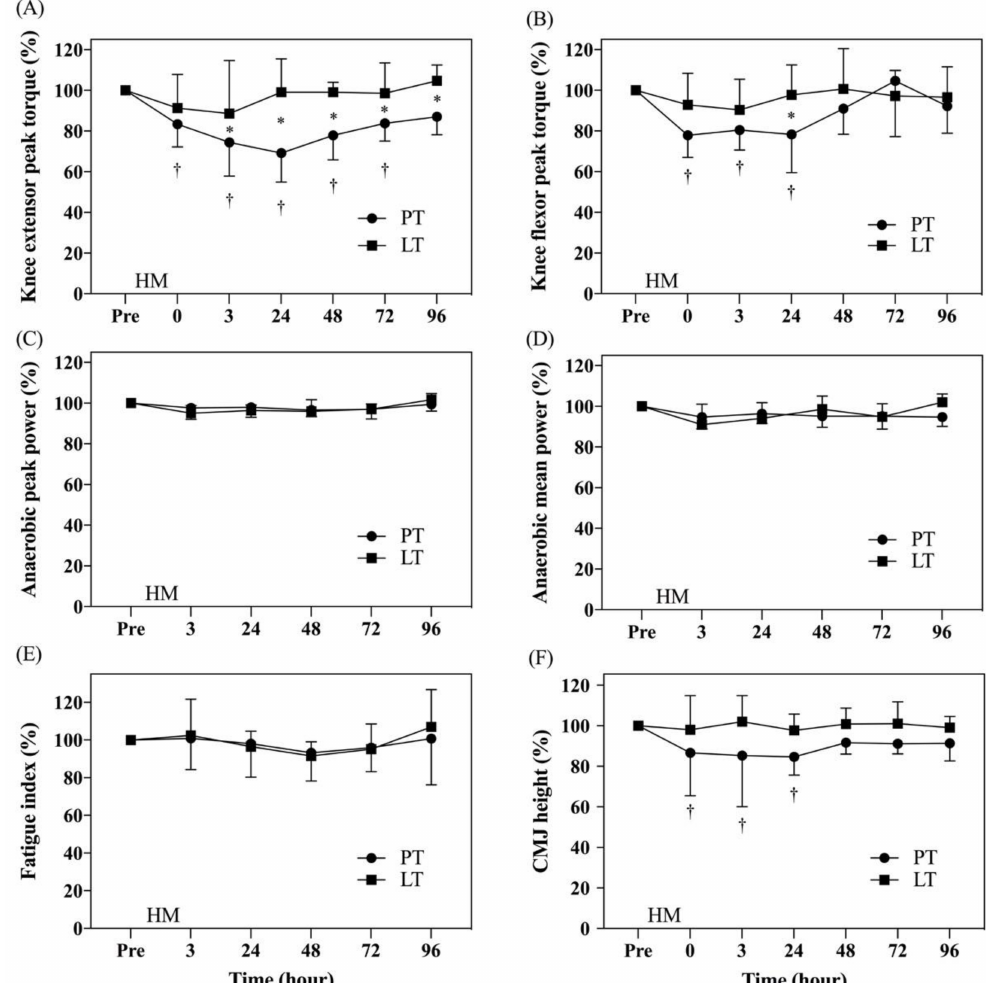
Figure 4. Comparison of normalized exercise capacity results. The data are represented as mean ± standard deviation. Knee extensor peak torque ( A ); knee flexor peak torque ( B ); anaerobic peak power ( C ); anaerobic mean power ( D ); fatigue index ( E ); countermovement jump (CMJ) height (F ). HM: half-marathon; † represents that there was a significant change from pre to post time points in the placebo treatment (PT); * represents that there was a significant difference at the same time point between PT and LT. p < 0.05 was considered to be a statistically significant difference within and between the